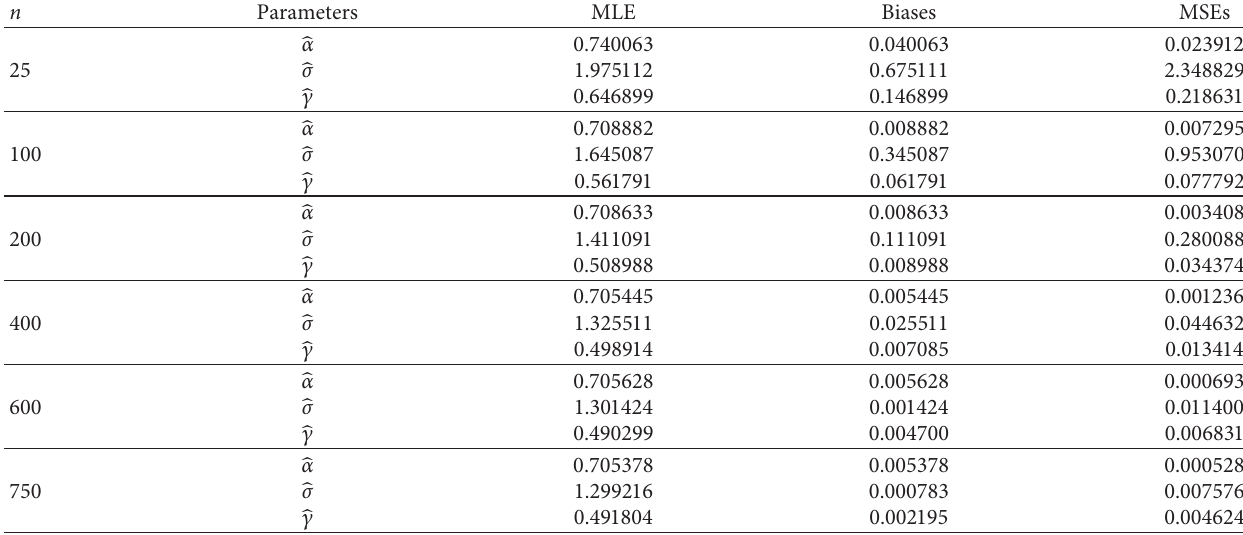
Table 1: Simulation results of the L-Claim distribution for α � 0 . 7 , c � 0 . 5, and σ � 1 . 3.